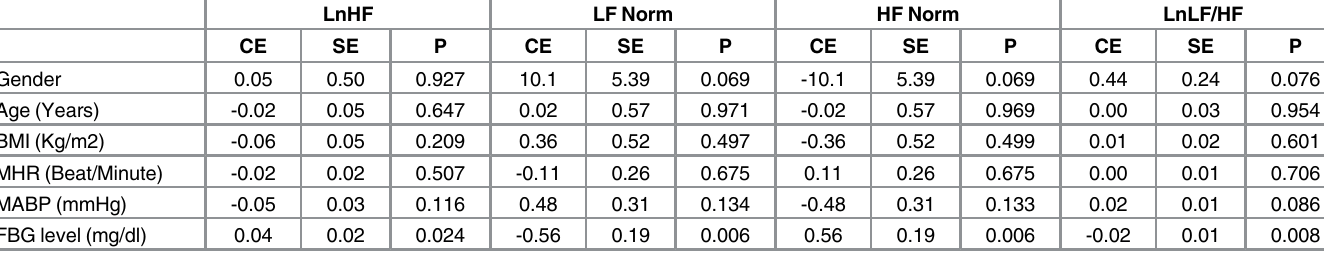
Table 3. Linear regression analysis of factors associated with LnHF, LF Norm, HF Norm and